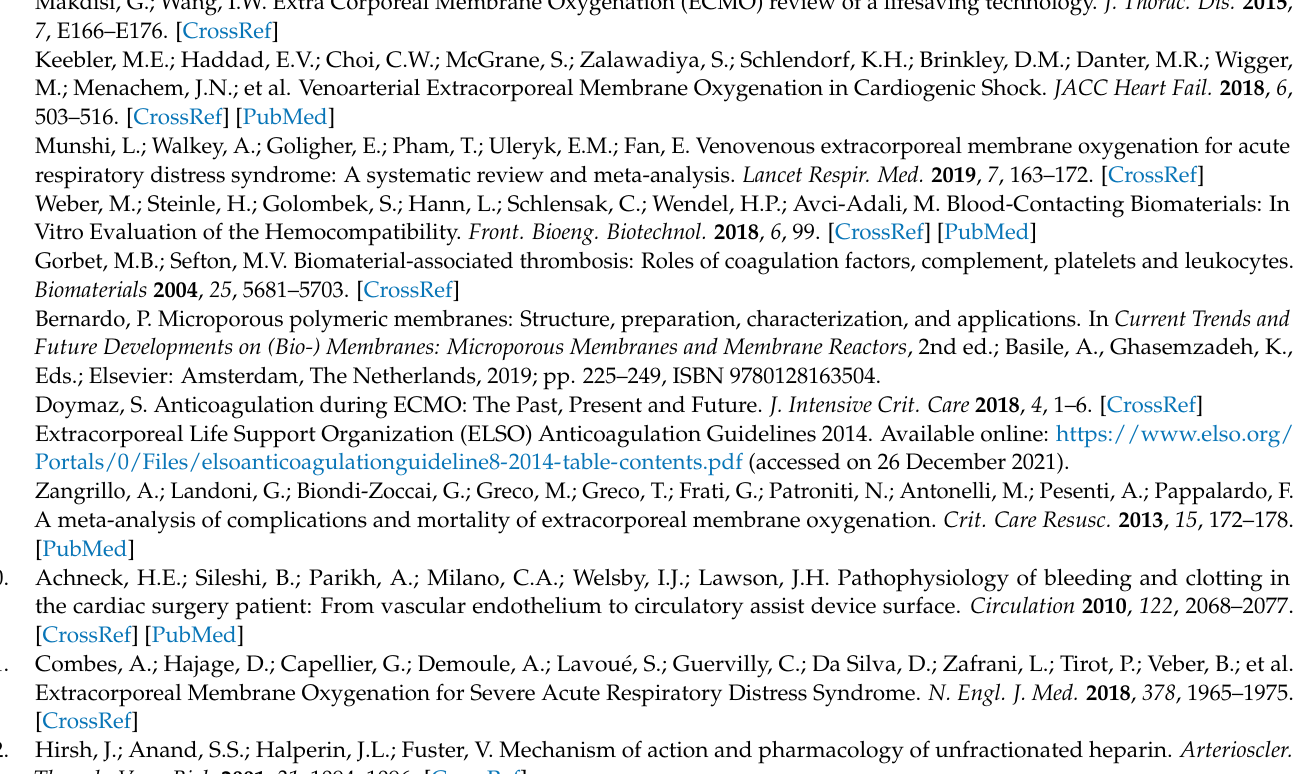
Figure S2: The proposed mechanism of NO-release, Figure S3: High-resolution N 1s XPS spectra of control and coated fibers before and after HBS, Table S1: The elemental composition of coated and control fibers before and after